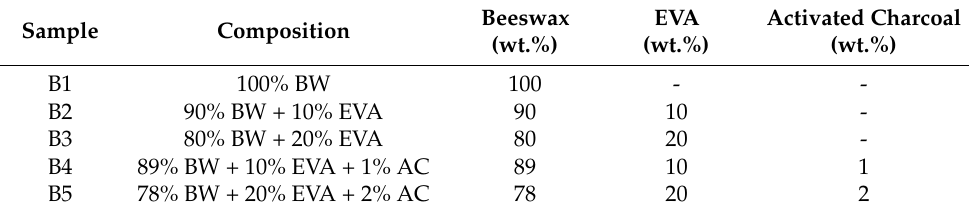
Table 2. Compositions of BW–EVA-based solid fuels.